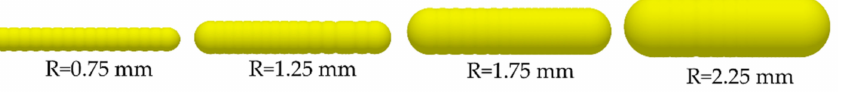
Figure 5. Multisphere models of SMR with different radii.